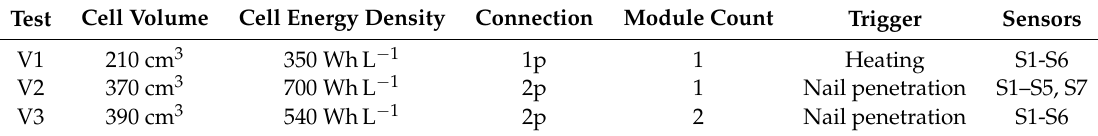
Table 2. Summary of conducted experiments. All tests have been carried out at a state of charge SOC = 100% and test V2 and V3 have been executed at T DUT = 60 ◦ C. Sensor labels reffer to Table